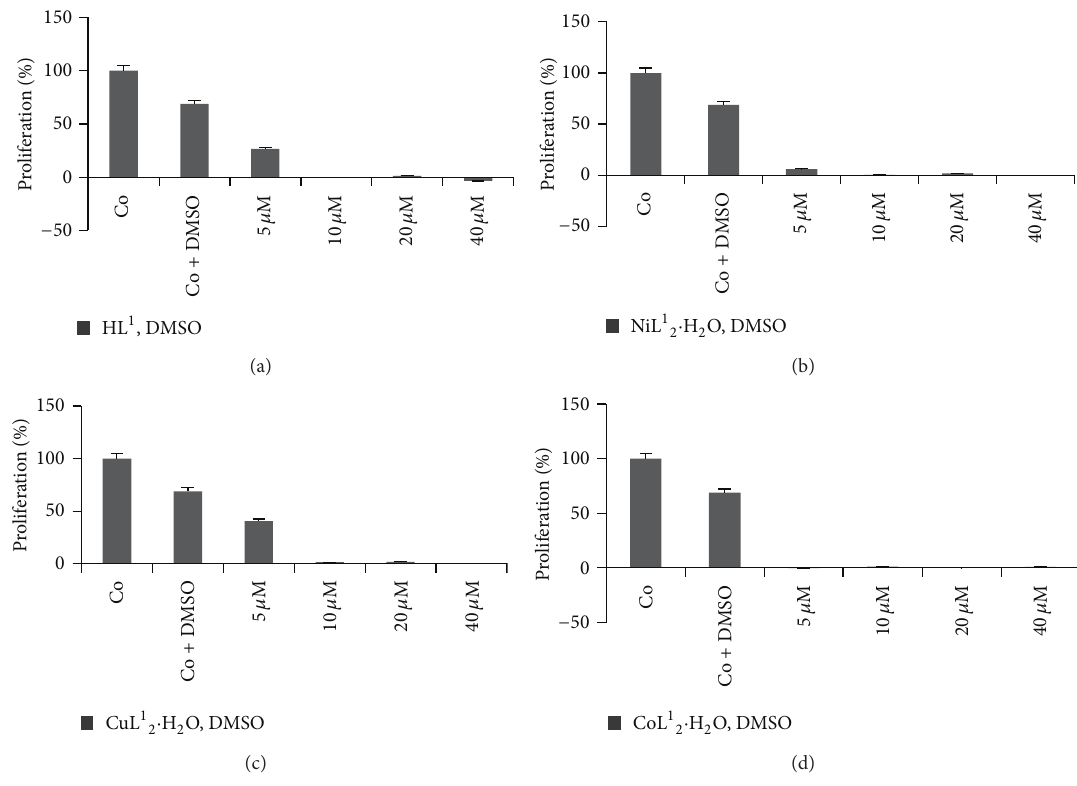
Figure 5: Inhibitory percentage (%) of compounds at 5–40 𝜇 M on HL-60 cancer cell